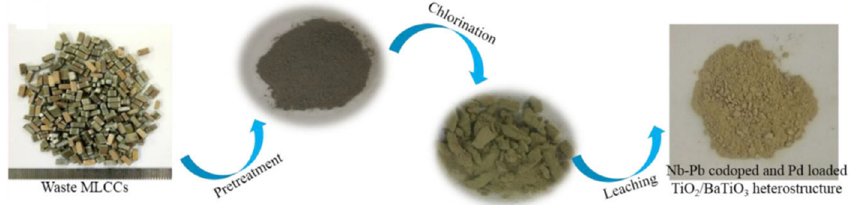
Figure 8. The multilayer ceramic capacitors (MLCCs) along with their constituents, including the in situ preparation procedure of Nb-Pb-co-doped and Pd-loaded TiO 2 /BaTiO 3 heterostructure, derived from waste MLCCs [111].